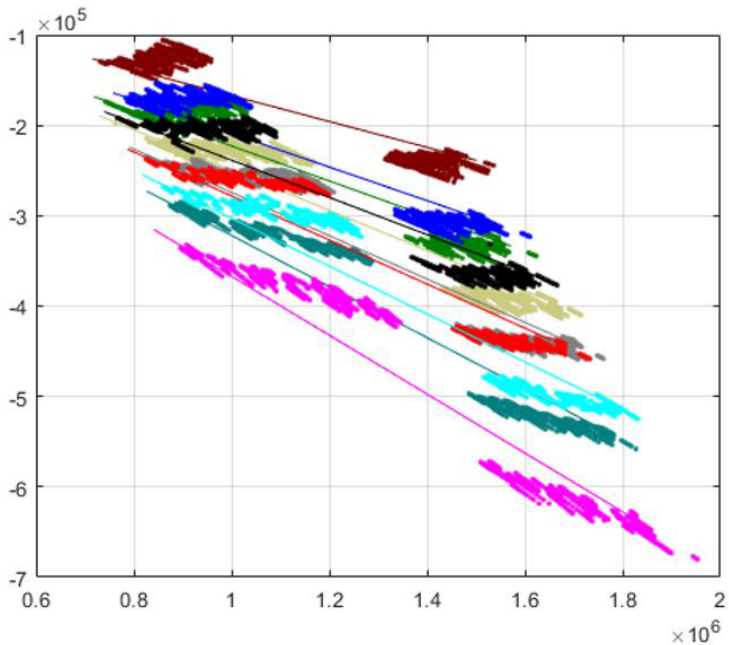
Figure 5. This represents the principal component analysis (PCA) results of ten representative in-air data, where each color represents a datapoint. A line in the same color is a basis line based on the PCA results of the in-air data.